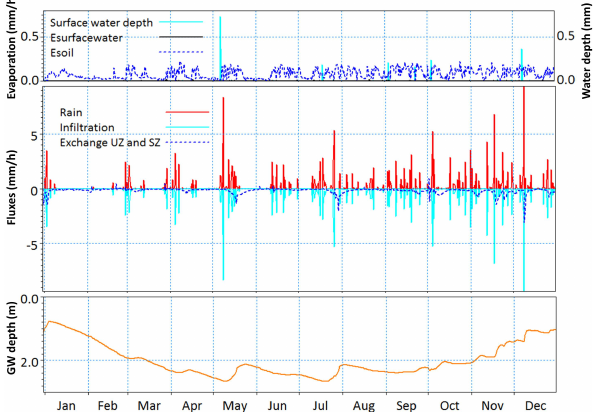
Fig. 4. Water balance at observation point (indicated in Fig. 2) in catchment equipped with bio-retention systems (Esoil: evaporation from soil; Esurfacewater: evaporation from surface water (under- neath by the dotted blue line); exchange UZ and SZ: exchange be- tween unsaturated and saturated zone; GW depth: groundwater ta- ble depth).